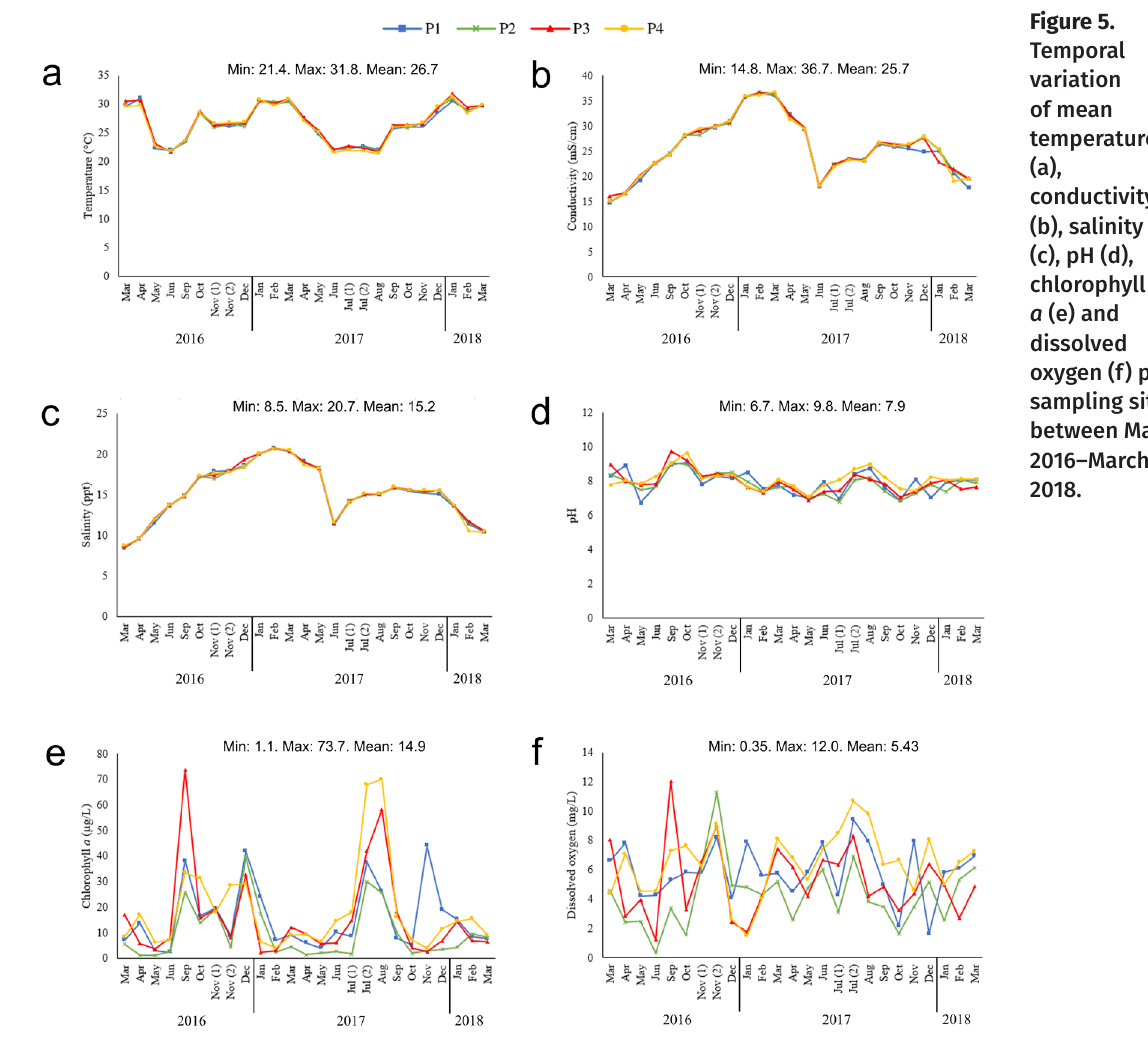
Figure 5. Temporal variation of